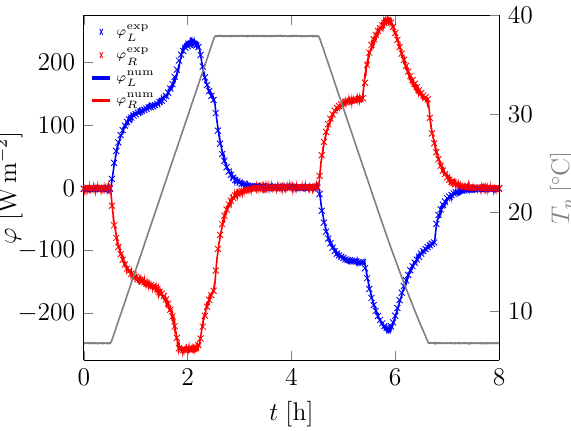
Figure 5. 12.4% w -PCM mortar: comparisons of the experimental fluxes with the numerical ones after identification for the first cycle of the 2h heating/cooling ramp